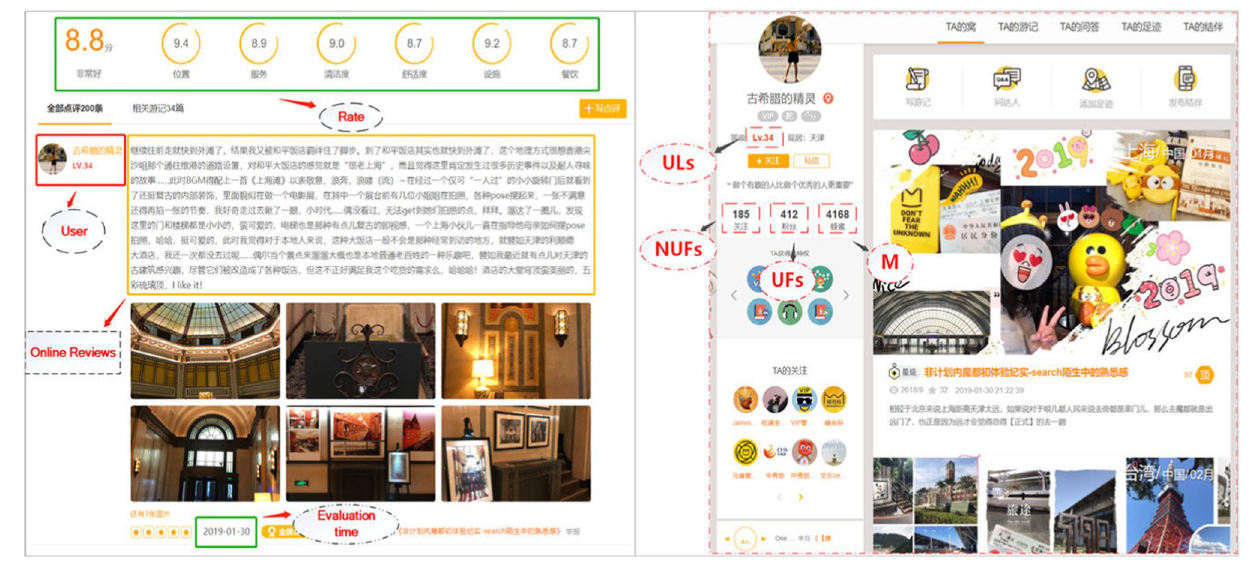
Fig. 3 A screen shot from Mafengwo.com